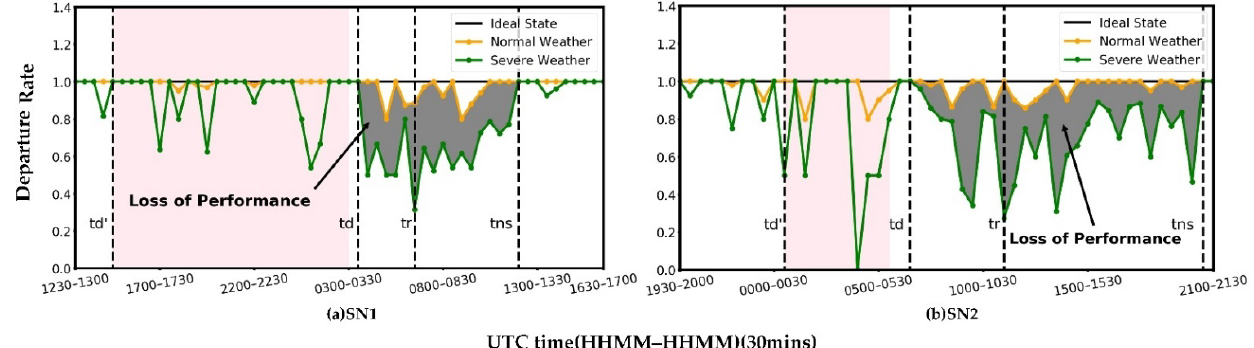
Figure 3. Airport flight operation resilience performance under SNs.